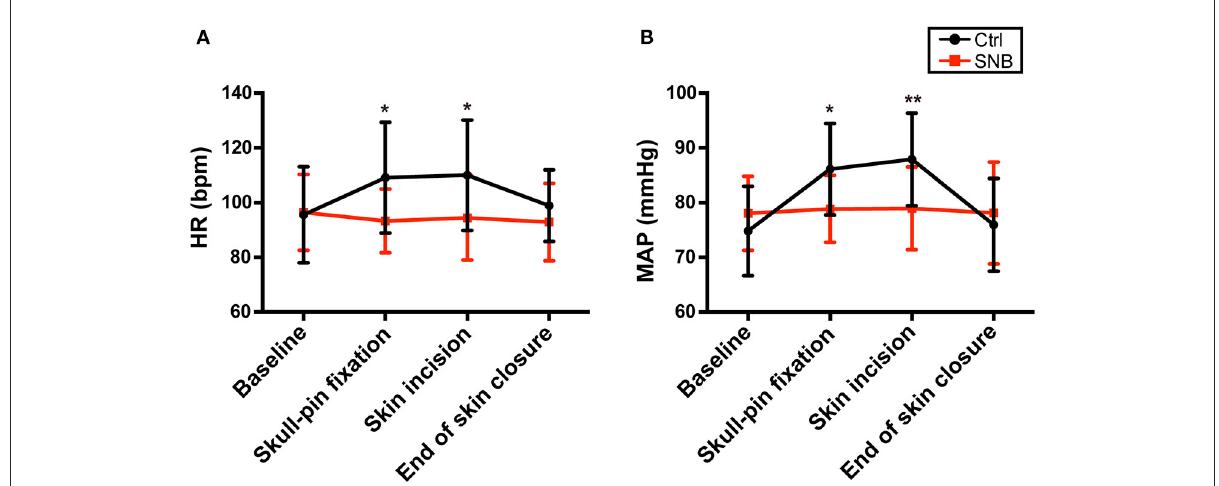
FIGURE2 The intraoperative hemodynamic variables (HR and MAP) in group Ctrl and group SNB. Changes in HR (A) and MAP (B) during baseline, skull-pin fixation, skin incision, and end of skin closure in group Ctrl and group SNB. MAP, mean arterial blood pressure; HR, heart rate. Data are presented as mean ± SD. * P < 0.05; ** P < 0.01. group Ctrl, control group; group SNB, scalp nerve block group.